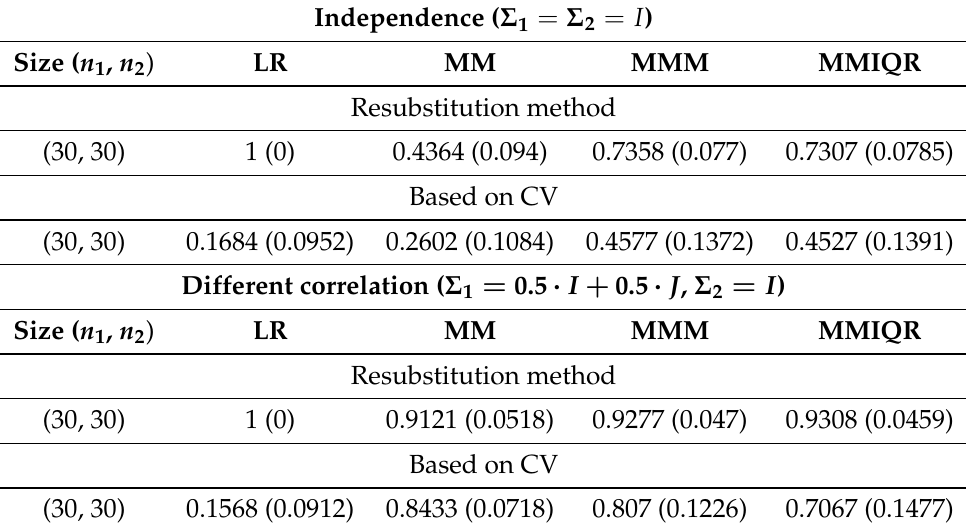
Table 4. Mean and standard deviation maximum Youden indices for 1000 random samples. High- dimensional scenarios ( p = 100): Normal distributions. Same means between